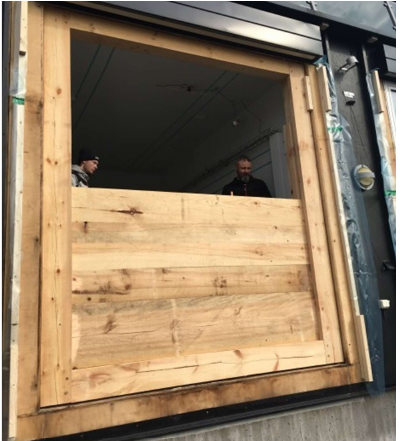
Appl. Sci. 2019 , 9 , x FOR PEER REVIEW Figure 5. The timber planks are fitted into place. Figure 5. The timber planks are fitted into place. Figure 5. The timber planks are fitted into place.